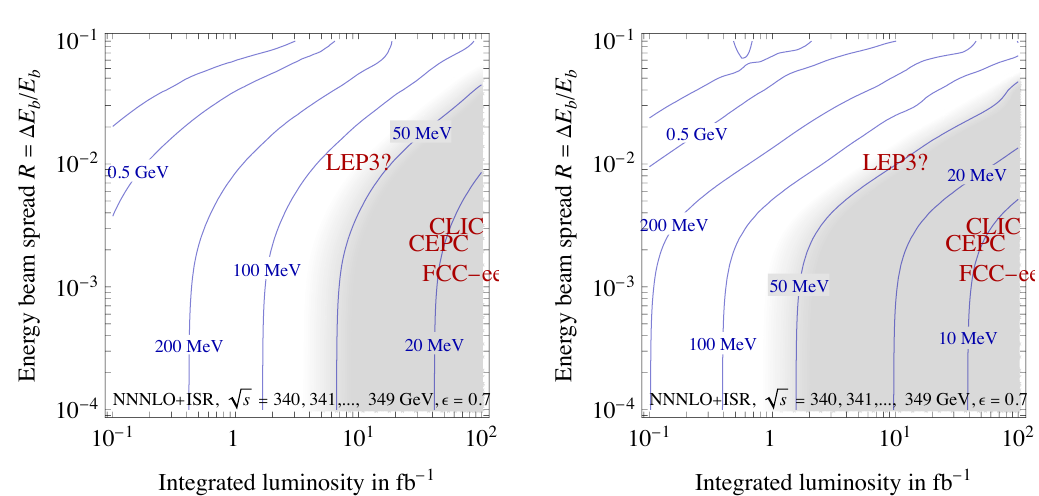
Figure 6 . As in figure 6, with Initial State Radiation effects included, as appropriate for a e − e +